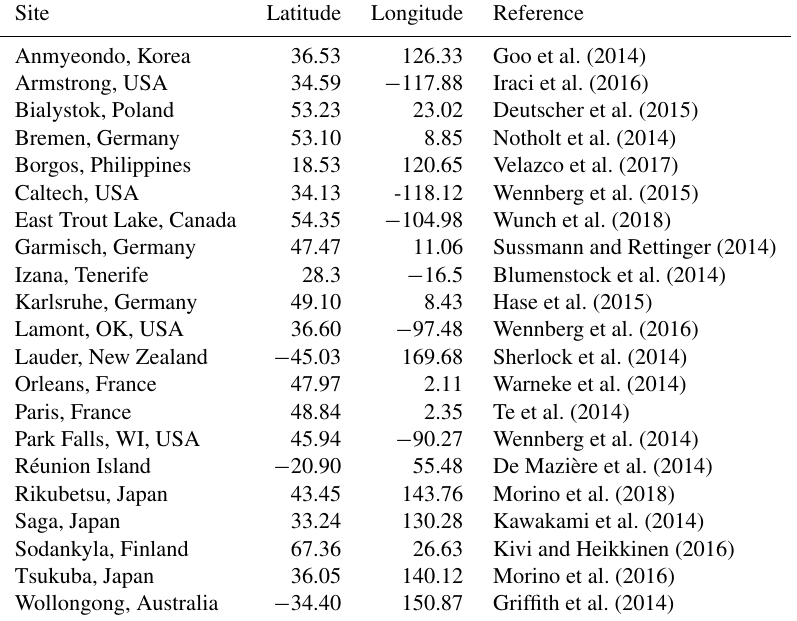
Table 1. List of TCCON sites and their